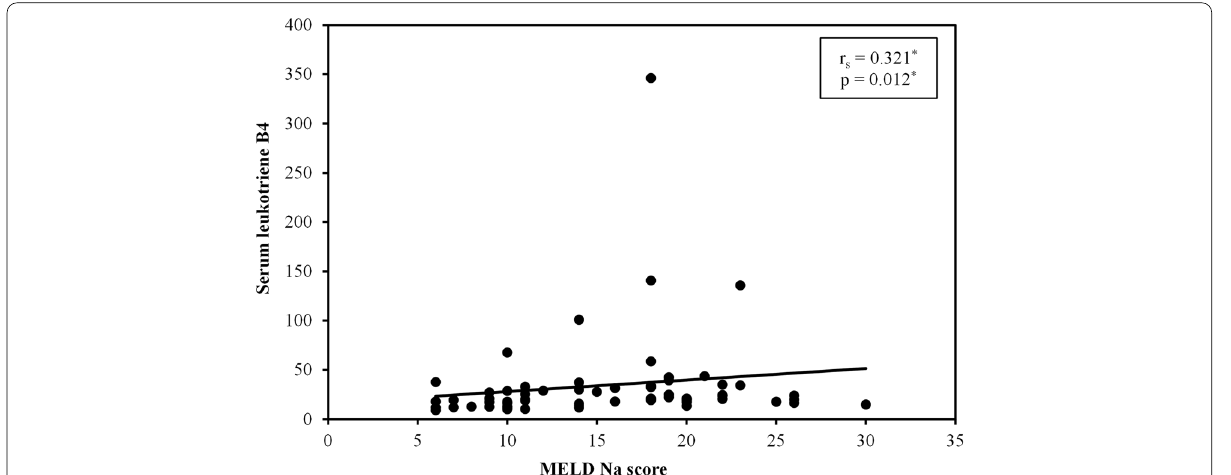
Fig. 4 Correlation between LTB4 and MELD/Na score in cirrhotic patients ( n